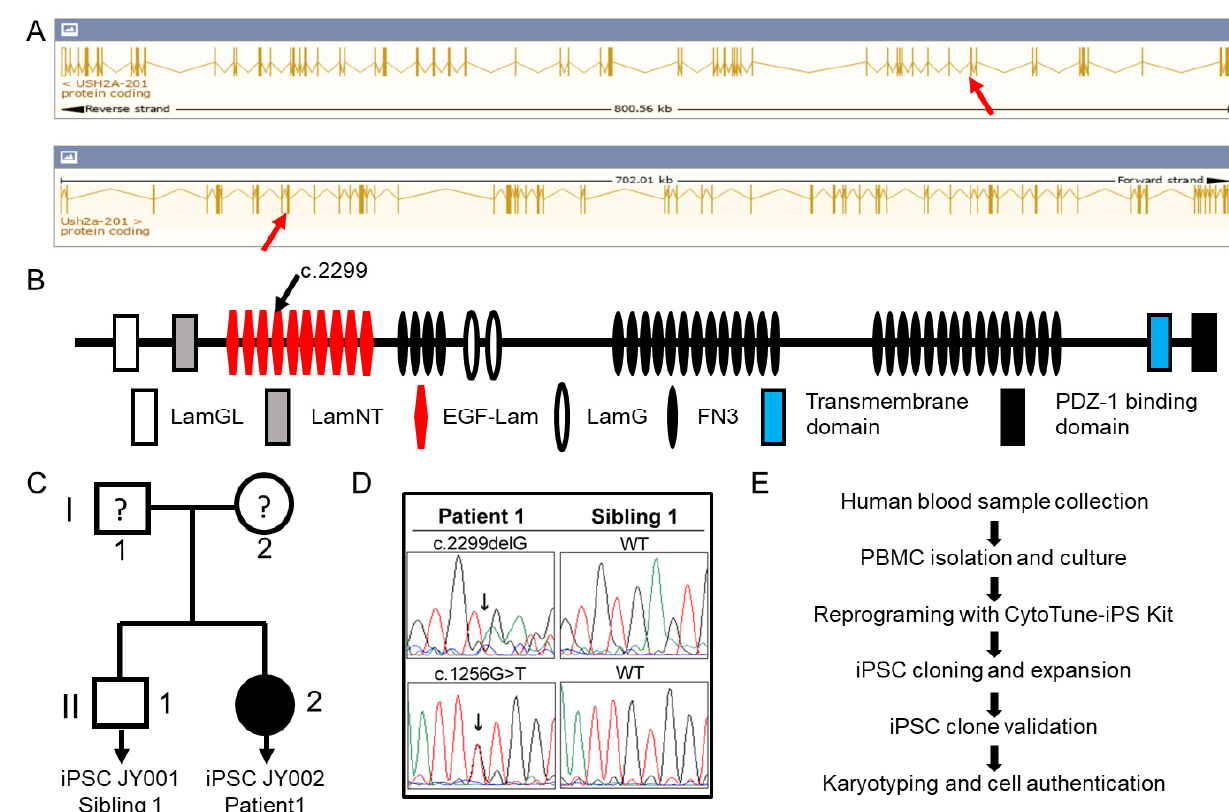
Figure 1. USH2A genomic structure, protein domain schema, pedigree information of human iPSC lines, and cell reprogramming. ( A ) Genomic structure of the human and mouse USH2A gene. A frequent mutation of c.2299delG is marked by a red arrow in the human gene (top) and mouse gene (bottom) (www.ensembl.org (accessed on 5/5/2020)). ( B ) Protein domain structure of the human USH2A. The c.2299delG mutation location is marked by a black arrow above the domain; ( C ) We generated two human PBMC-derived iPSCs, labeled with JY001 and JY002. Line 1, JY001, was a health control; line 2, JY002, was diagnosed as USH2. JY001 and JY002 are siblings as indicated. The “?” mark stands for unknown phenotype and genotype. ( D ) The sequencing chromatograms of genetic mutation sites of patient 1 are presented along with those of her unaffected sibling. ( E ) Procedural flowchart of human PBMC reprogramming with four transcription factors.